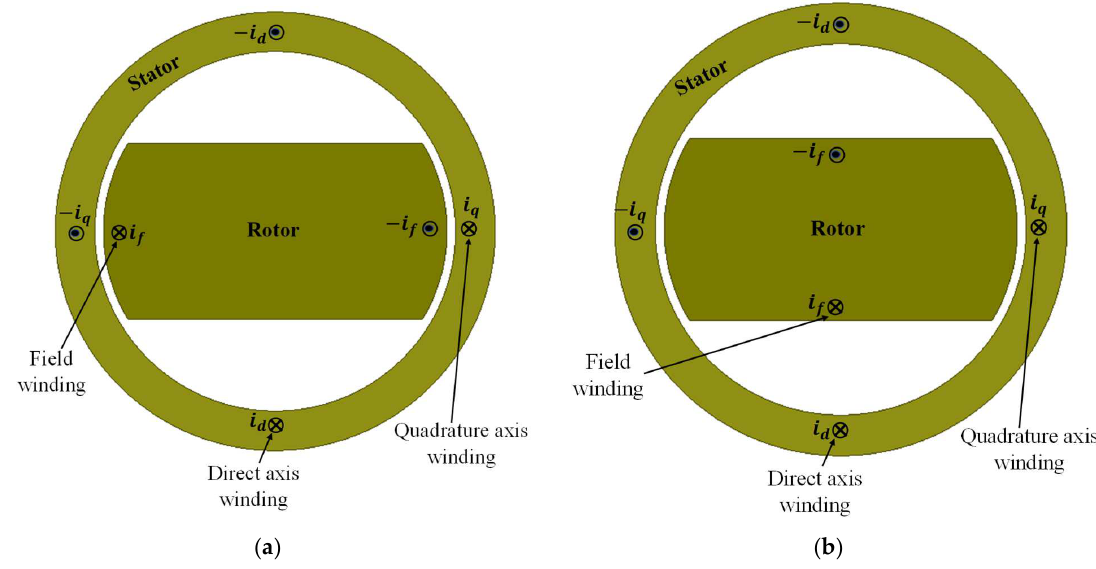
Figure 7. RSM topologies: ( a ) CRSM rotor and ( b ) ARSM rotor.